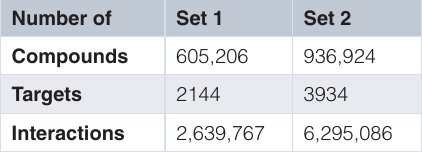
Table 5. Low-confidence data